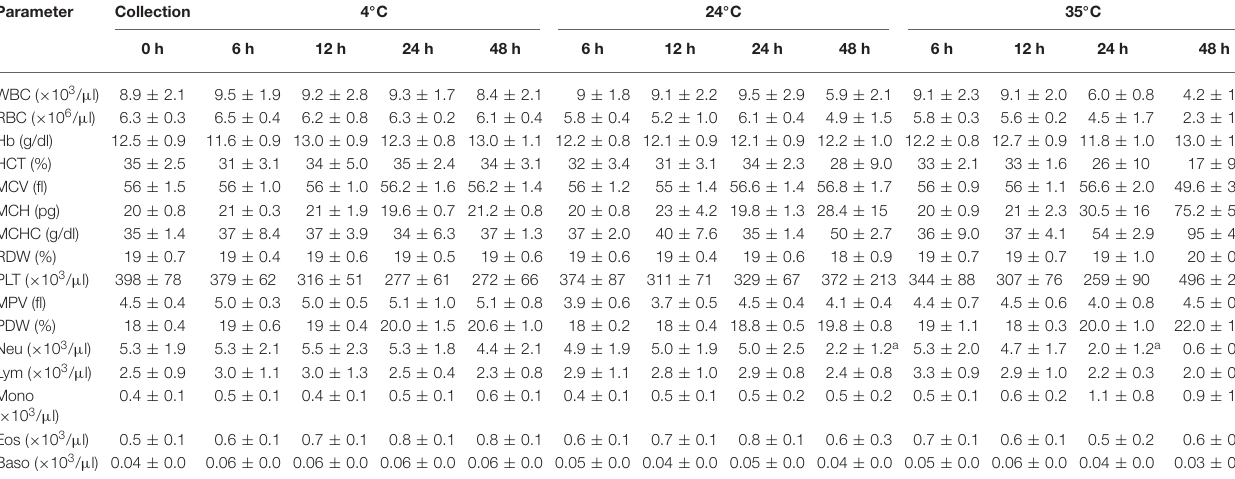
TABLE 1 | Effect of temperature and storage time on blood samples from healthy donkeys. Parameter